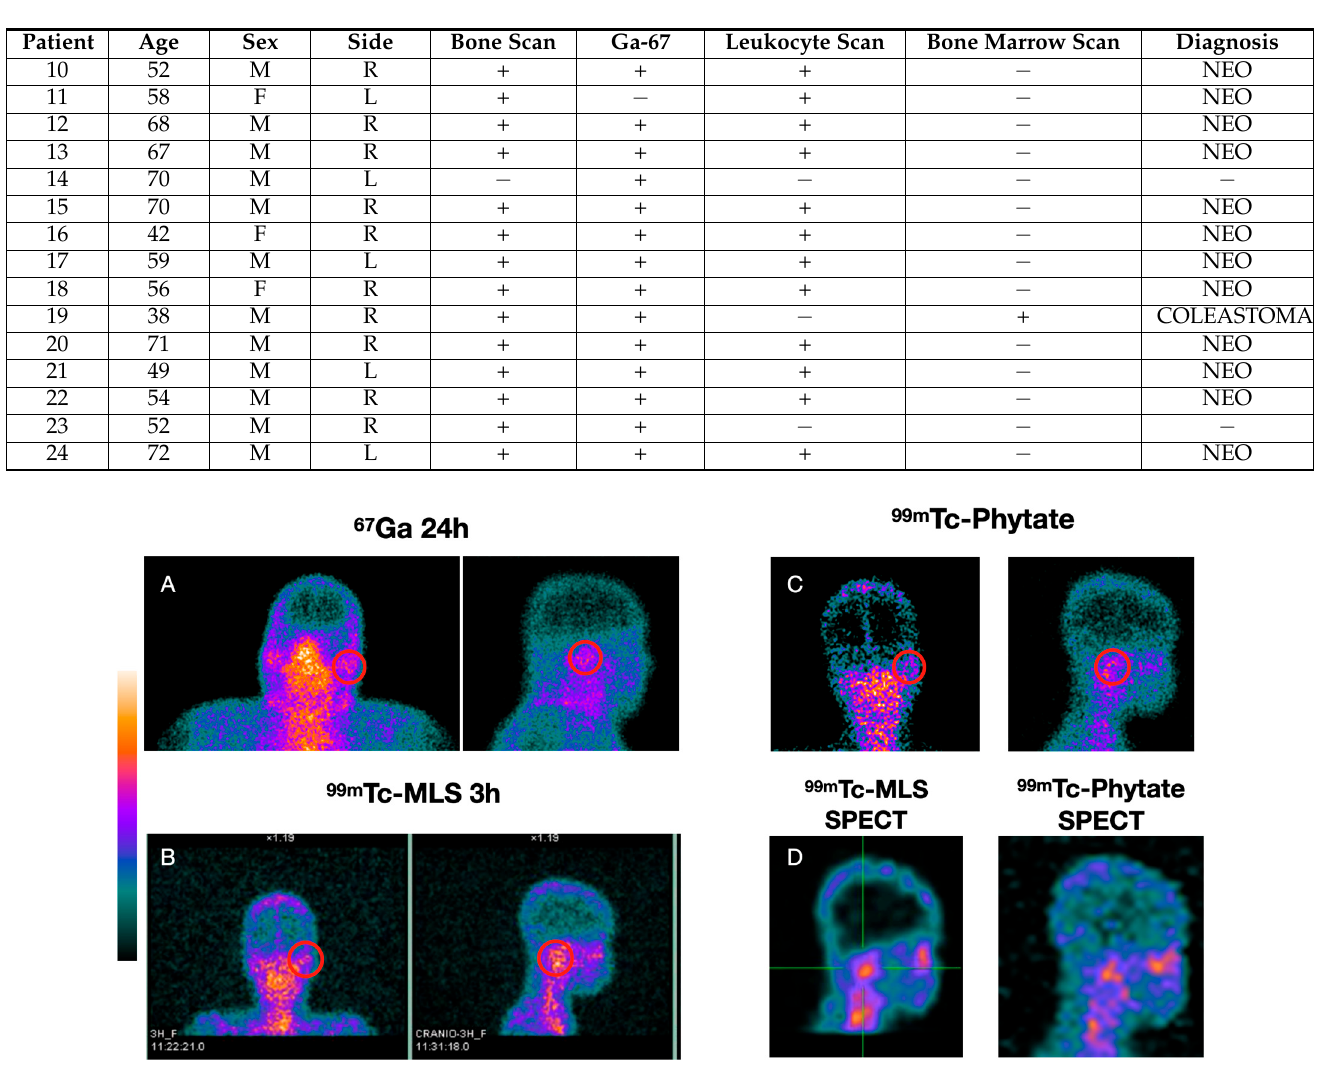
Figure 2. Patient 6. A male, 21 year-old patient with acute myeloid leukemia in remission with NEO suspicion in his right ear. Returning lab results revealed Pseudomonas aeruginosa positive culture, although no improvement was found after antibiotics treatment. Bone 99m Tc-MDP and 67 Ga scintigraphy ( A ) were positive at the right mastoid topography. Both findings are in agreement with the infectious–inflammatory process in the temporal bone hypothesis. High uptake in 99m Tc-MLS in right mastoid topography (posterior and lateral incidence) 1 and 3 h ( B ) after labeled cells injection and enhanced with 99m Tc-phytate showing uptake in the same topography ( C ). SPECT ( D ) from 99m Tc-MLS and 99m Tc-phytate revealing the agreement in the uptake putting aside the infectious process possibility. After 6 weeks of antibiotics, a neoplasm was considered, and a biopsy revealed a myeloid sarcoma.